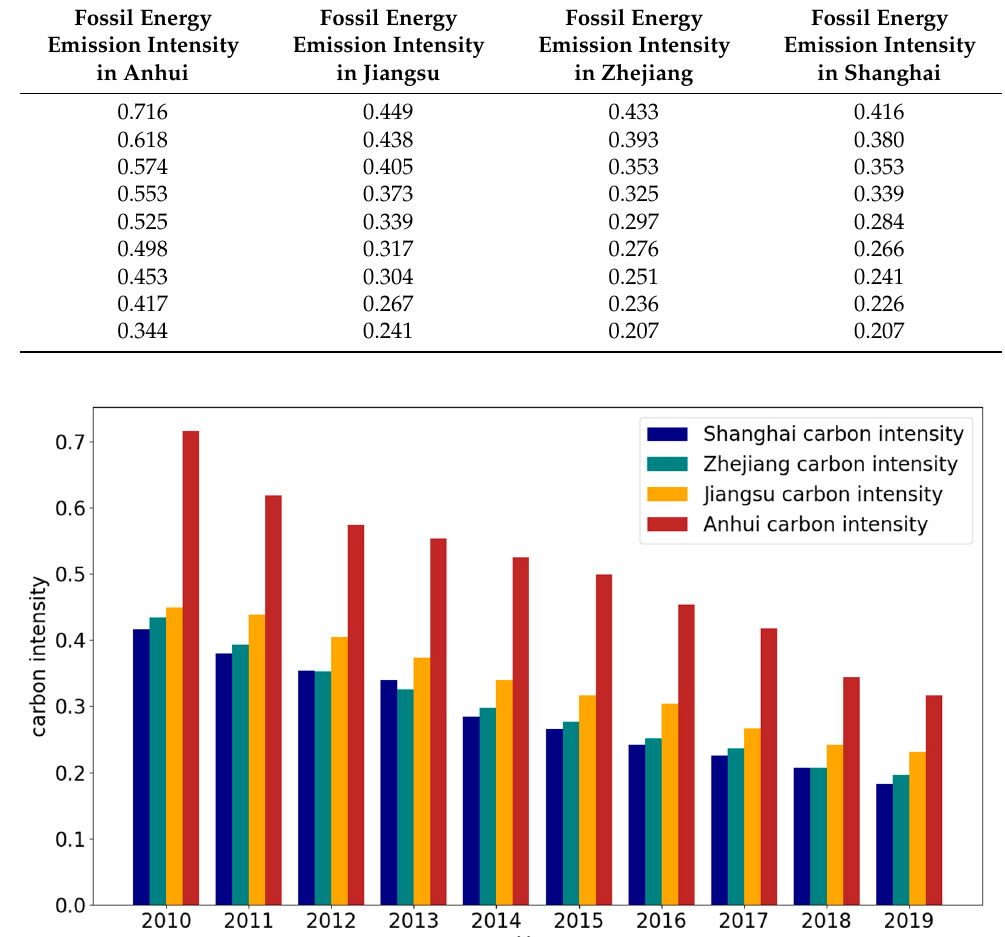
Figure 5. Carbon emission intensity of three provinces and one city in the YRD Region from 2010 to to 2019.